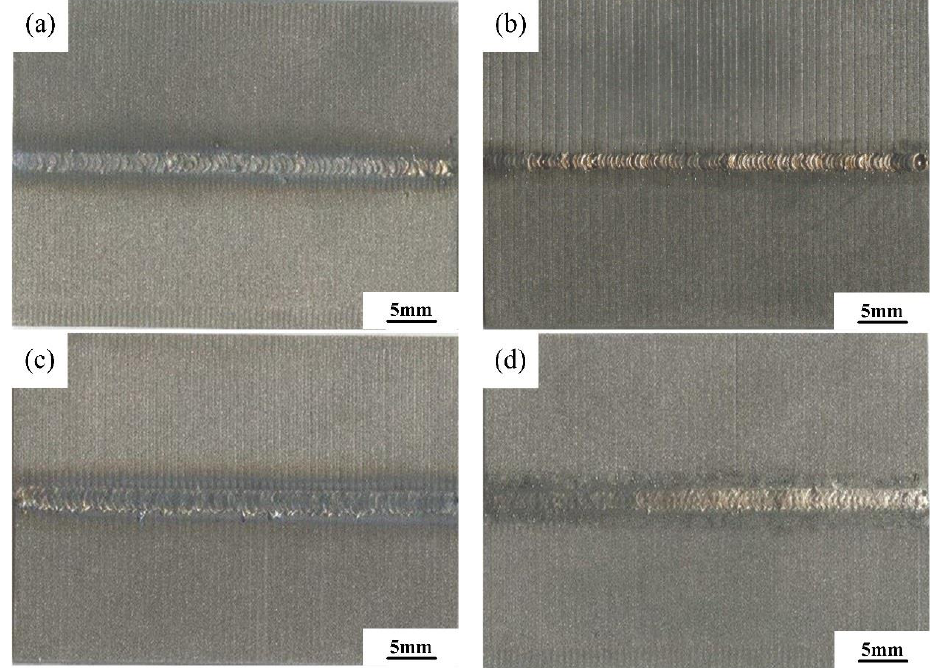
Figure 4. The face and back morphology of laser-welded joints: ( a ) face of weld without filler metal; ( b ) back of weld without filler metal; ( c ) face of weld with Nb filler metal; and ( d ) back of weld with Nb filler metal.